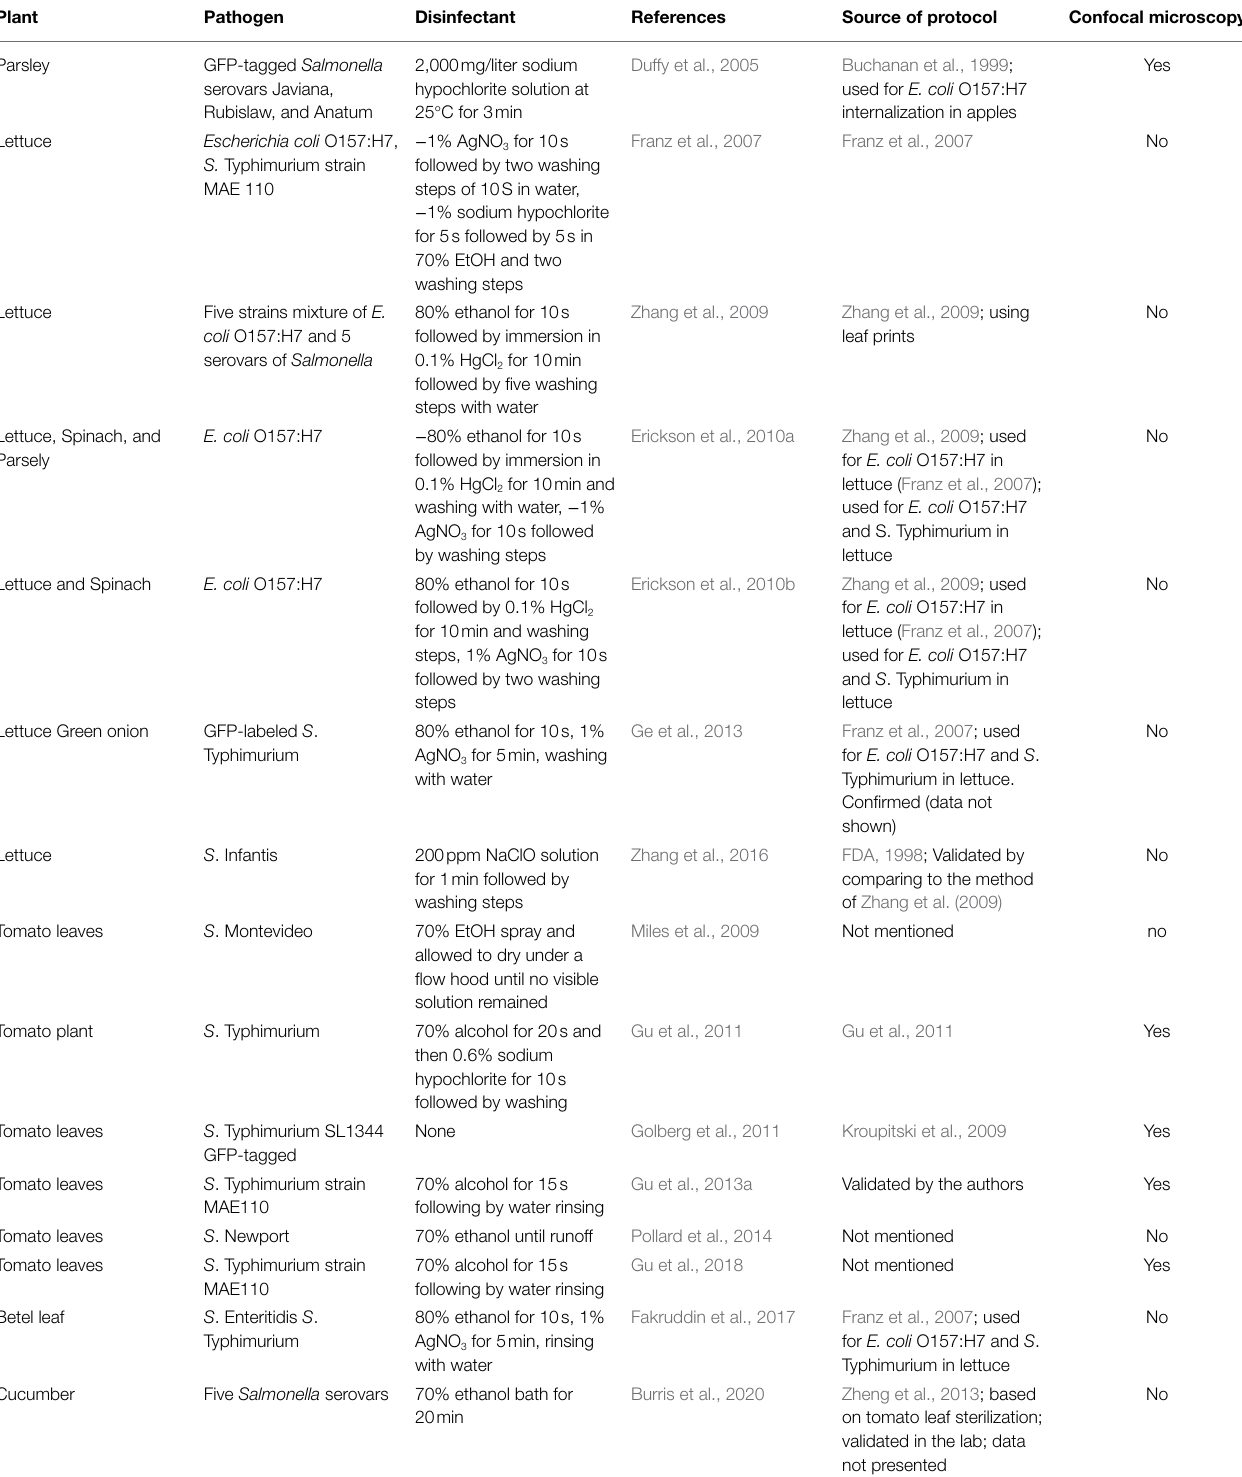
TABLE 1 | List of selected reports on leaf internalization of human enteric pathogens and the method used to study bacterial localization. Plant